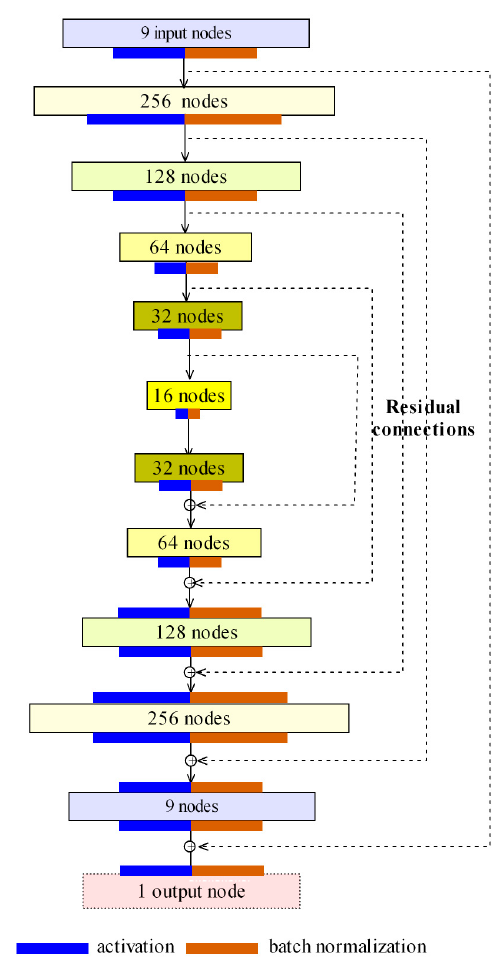
Figure 4. Autoencoder-based deep residual network for wind speed (9 input variables).